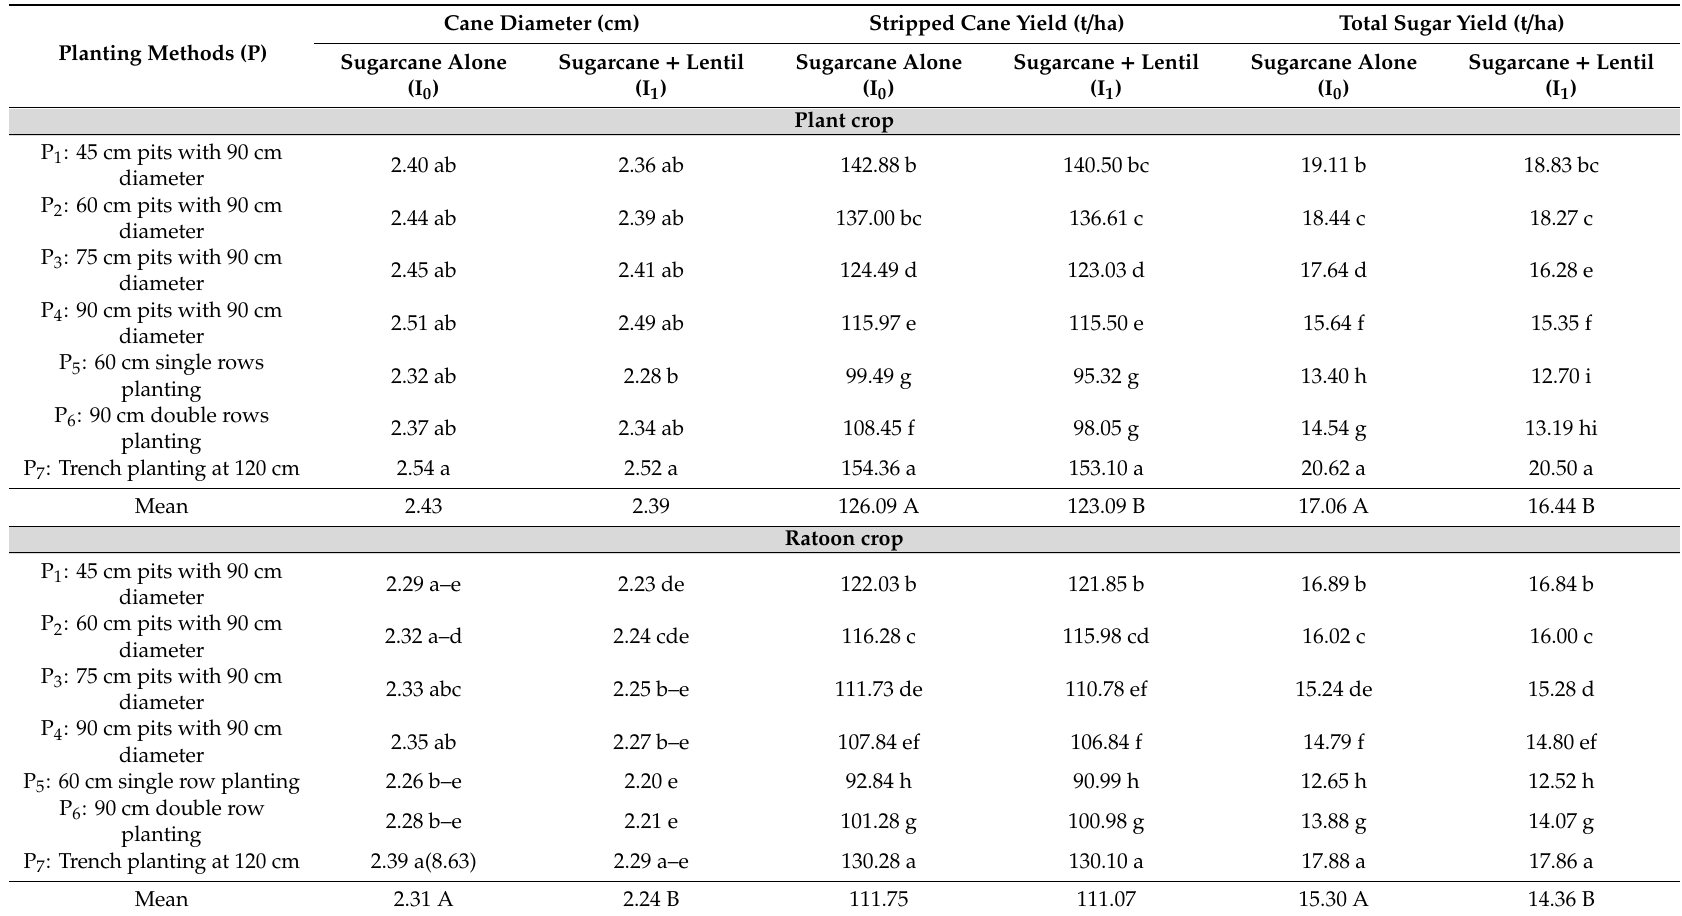
Table 3. Yield and quality of sugarcane under di ff erent planting patterns with lentil